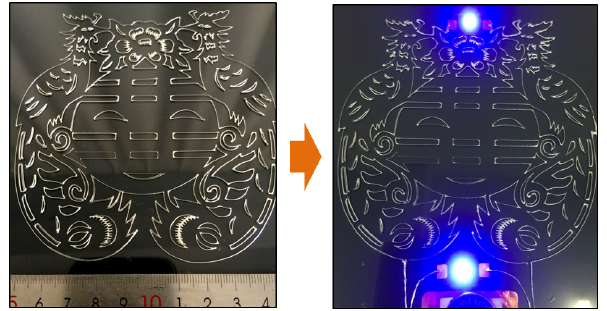
Figure 13. The direct-writing conductive circuit with customized